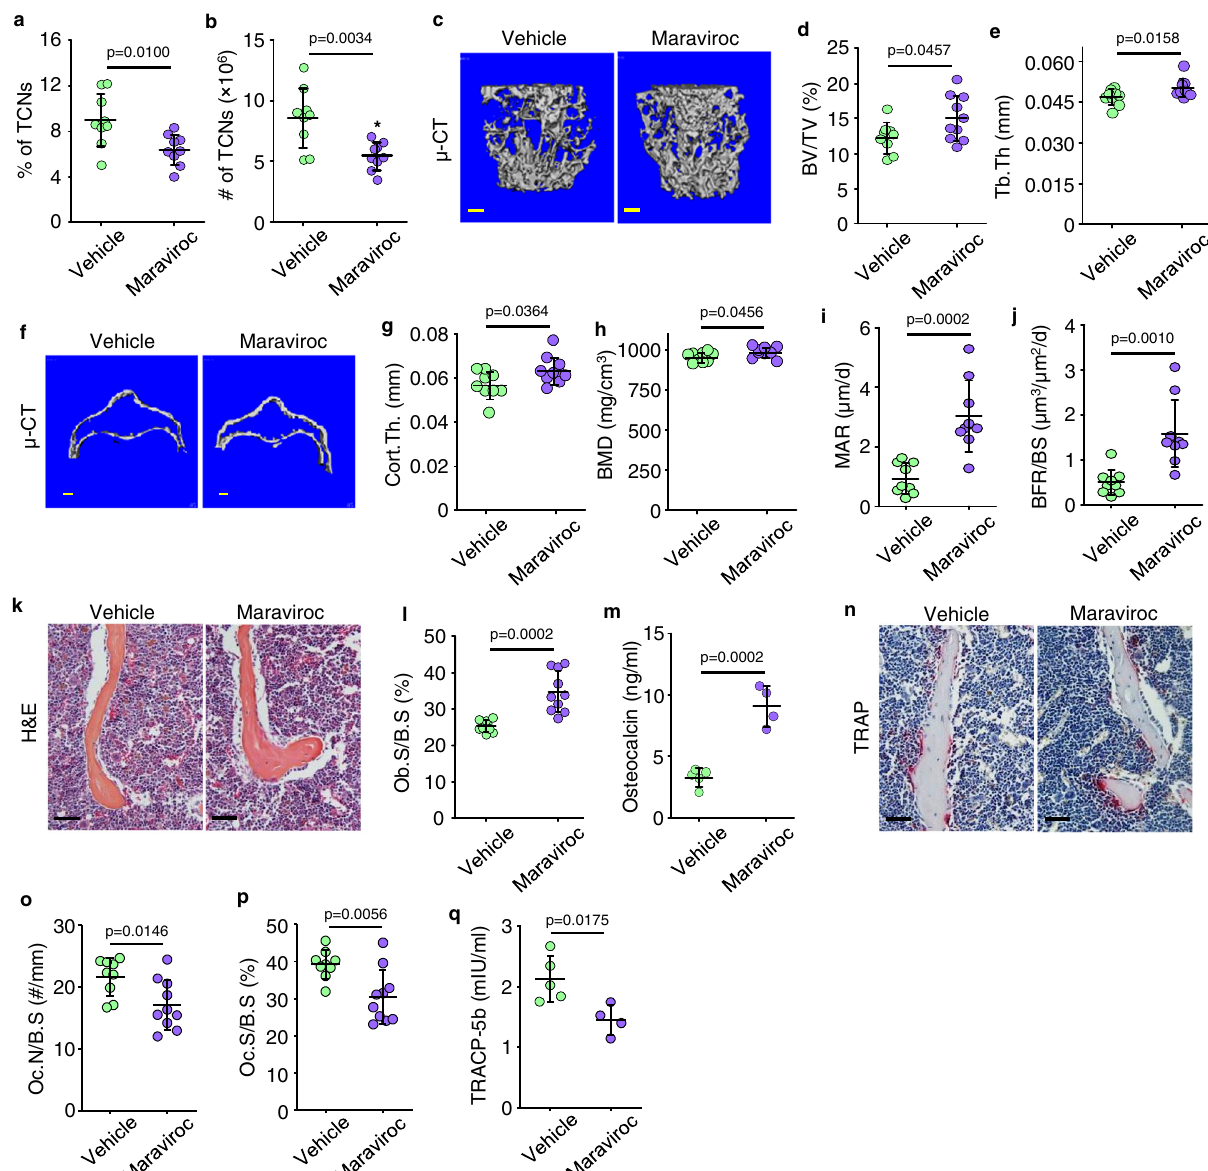
Fig.7|AgedmicetreatedwithmaravirochavefewerTCNsinBMandincreased bone mass. a , b Frequencies ( a ) and numbers ( b ) of TCNs in BM of 22-mon-old maleC57micetreatedwithvehicleormaraviroc(10mg/kg)once/ds.c.for1month. Mean±SD ( n =9 and 10 biologically independent male mice for vehicle and maraviroc-treatedgroups,respectively). c – e μ CT3DreconstructionofL1vertebrae ( c ) and values for trabecular bone volume (BV/TV) ( d ) and thickness (Tb.Th) ( e ). Bar=1mm. Mean±SD ( n =9 and 10 biologically independent male mice, respec- tively). f – h Horizontal sections of μ CT 3D reconstruction of cortical bones of L1 vertebrae ( f ) and values for cortical bone thickness (Cort.Th) ( g ) and bone mineral density (BMD) ( h ). Bar=1mm. Mean±SD ( n =9 and 10 biologically independent male mice, respectively). ( i , j ) Bone formation parameters including mineral